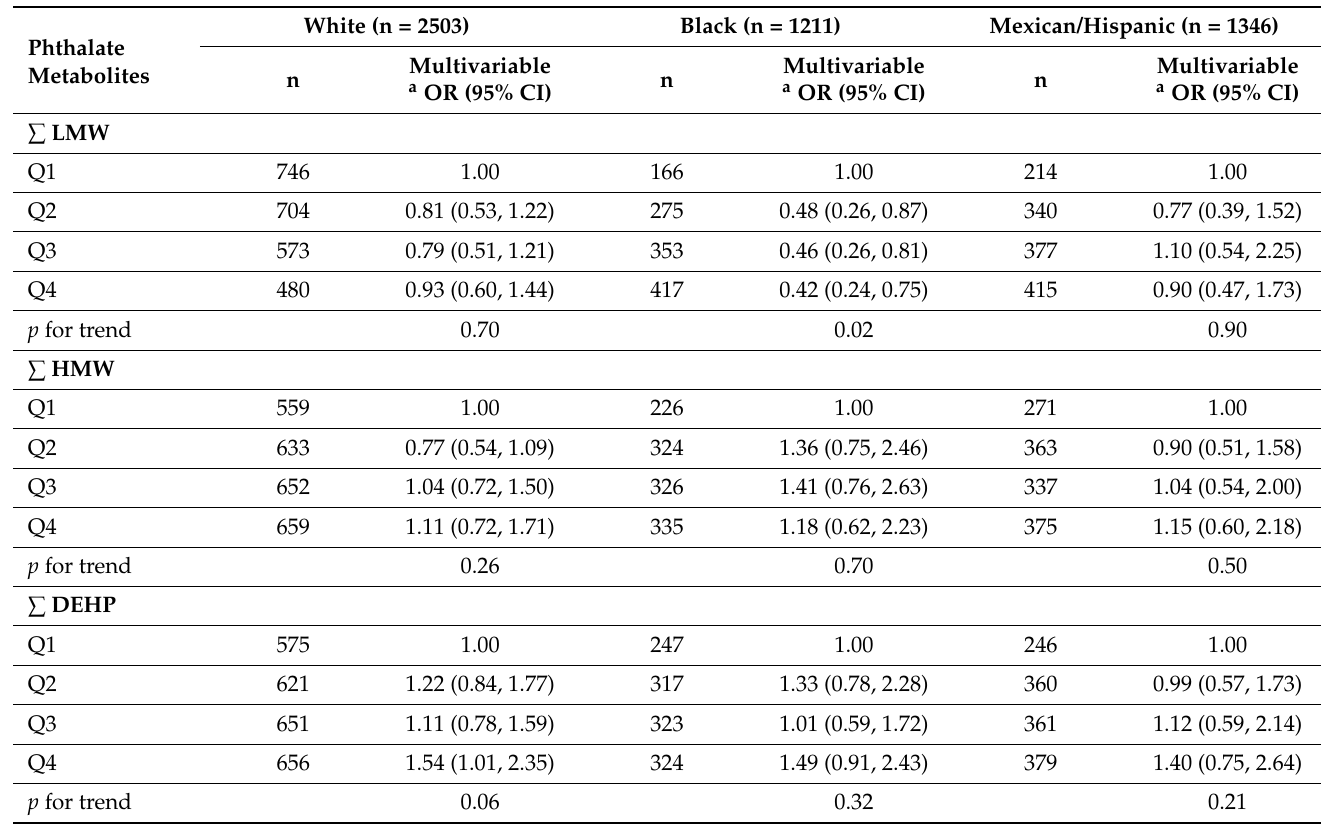
Table 6. Associations between urinary phthalate metabolite summary measures and metabolic syndrome among men by race, NHANES (2005–2014).